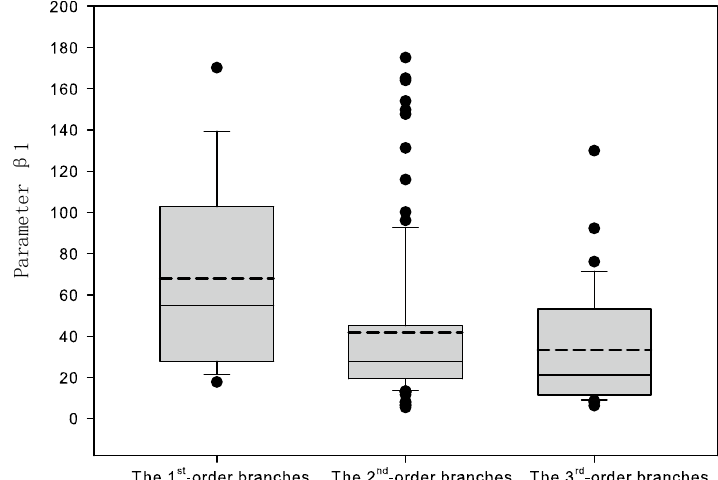
Figure 3. Box- plots of parameters β 1 an d β 2 for the first-order branches, the second-order branches, and the third-order branches (dashed line indicates the mean